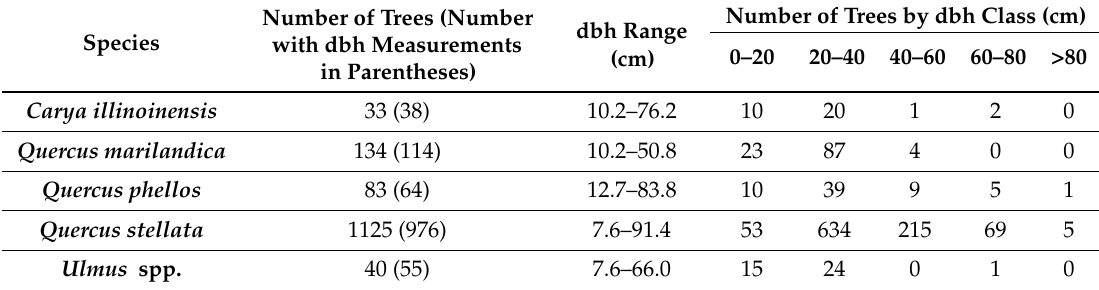
Table 7. dbh data for the five most frequently occurring trees in the presettlement forests in Brazos